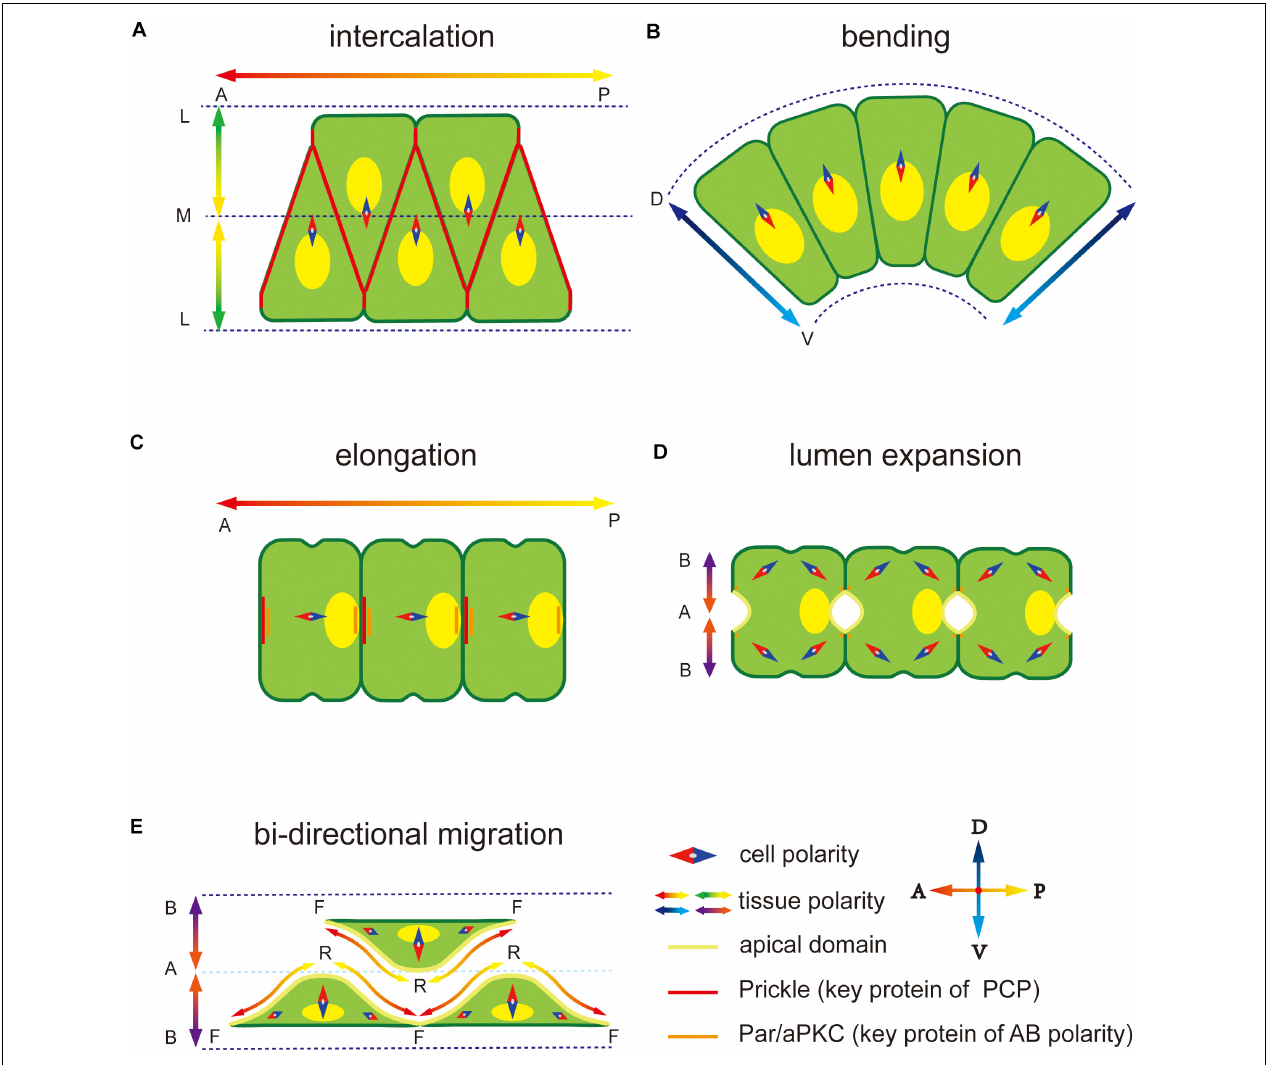
FIGURE 1 | Polarity at different notochord development stages in Ciona . (A) Notochord cells form a mediolateral (ML) polarity to drive the migration to the midline during convergence and extension. The notochord elongates parallel to the anterior-posterior (AP) axis regulated by embryonic AP polarity signaling. The key PCP component protein Prickle is located at the notochord cell–cell contact domain. (B) Notochord cells form a dorsal-ventral (DV) polarity to abend tissue toward the ventral side. (C) After cell intercalation, the PCP direction changes from ML to 1D AP axis. The Prickle relocates at the anterior edge of each notochord cell. (D) Apical-basal (AB) polarity is built to induces extracellular lumen formation. Two apical domains appear in one notochord cell. (E) Notochord cells migrate bidirectionally to induce the lumen connection. Adjacent notochord cells flatten opposite to each other along the notochord